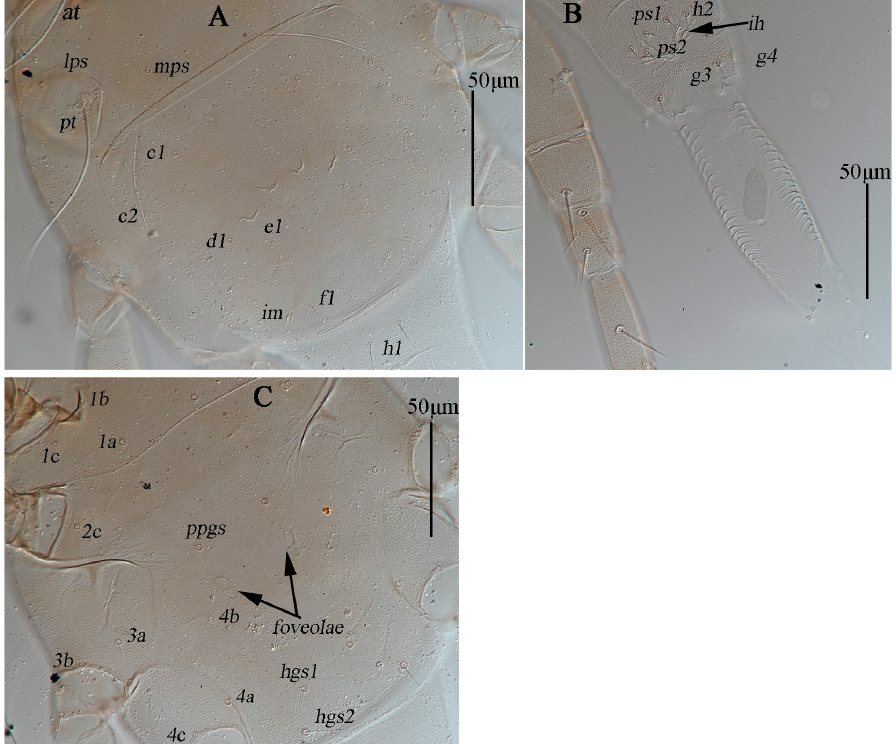
Figure 3. Cunaxicaudus mohanensis sp. nov. (male). ( A , B )—Dorsal idiosoma (photo). ( C )—Ventral idiosoma (photo). Scale bar = 50 µm.